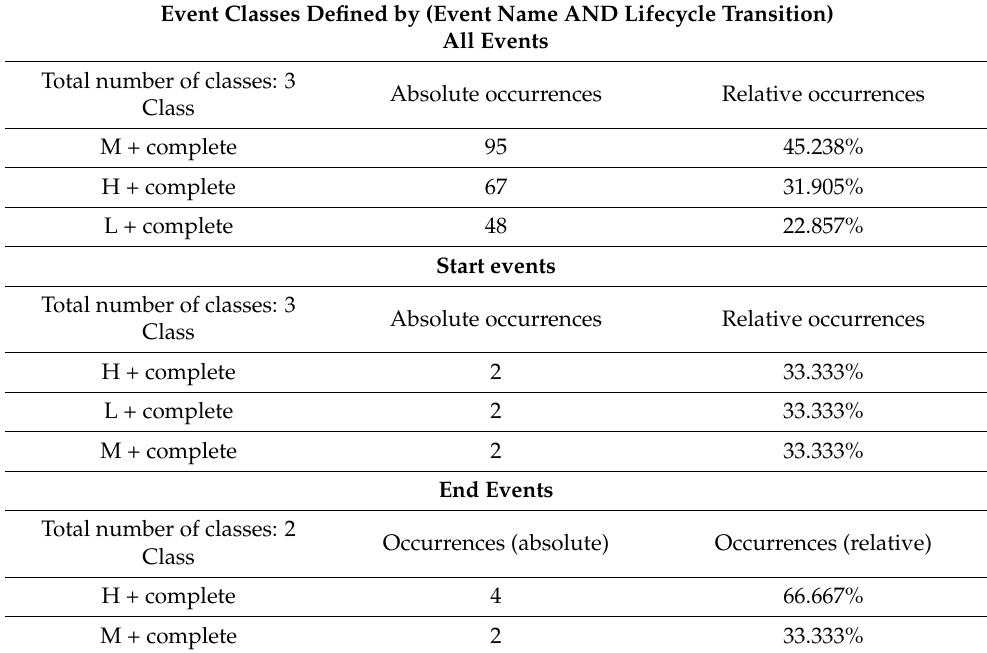
Table 3. Distribution of process instances for students’ classes in the event logs.